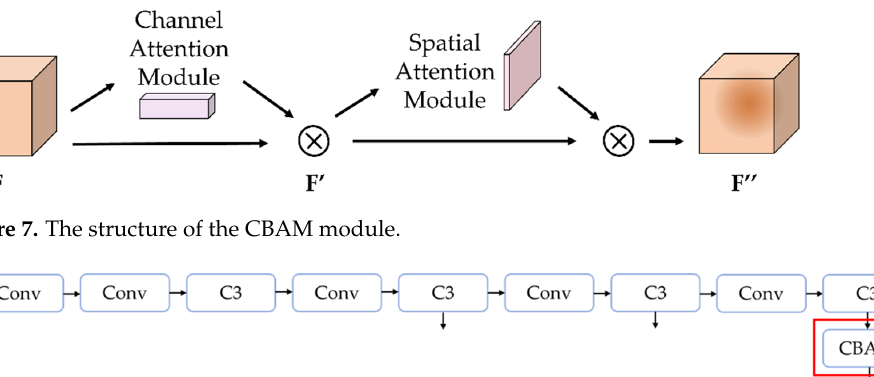
Figure 8. The location of the CBAM added in the network.